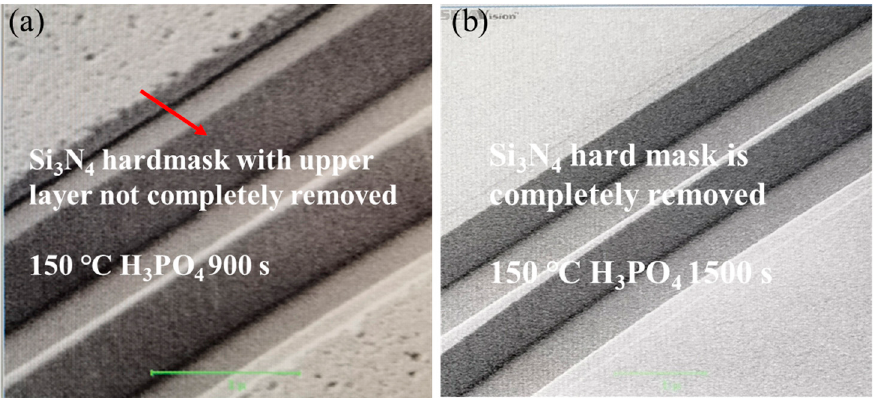
Figure 10. SEM images of the waveguide structure after HM removal. ( a ) partially removed HM, ( b ) fully removed HM.